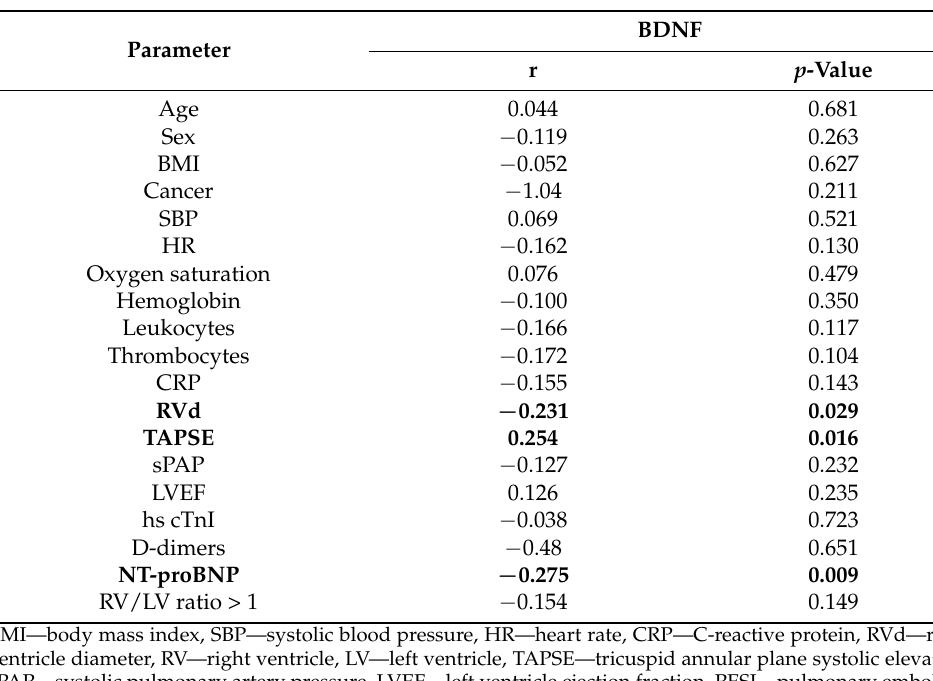
Table 4. Correlations between BDNF levels and clinical and paraclinical parameters in the PE group.